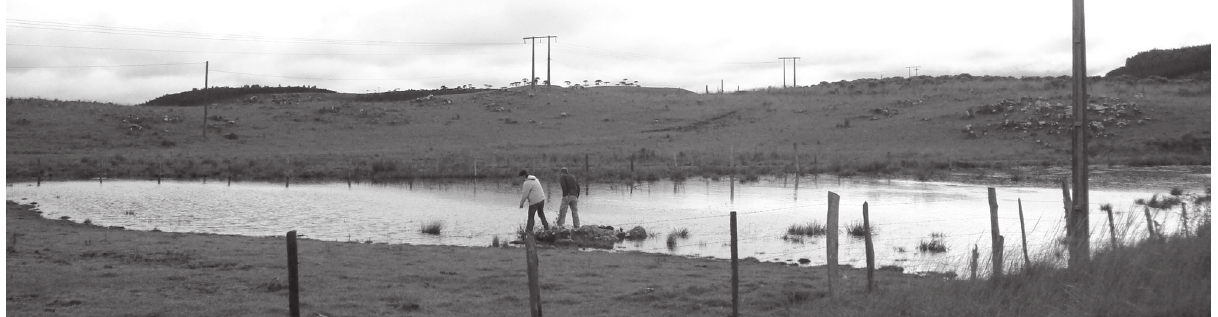
Figure 2. General view of the roadside pool at São Joaquim, Santa Catarina, Brazil. The surrounding winter-killed vegetation evidences the frequent frosts in this region. The pool is possibly formed by accumulation of rainwater in a